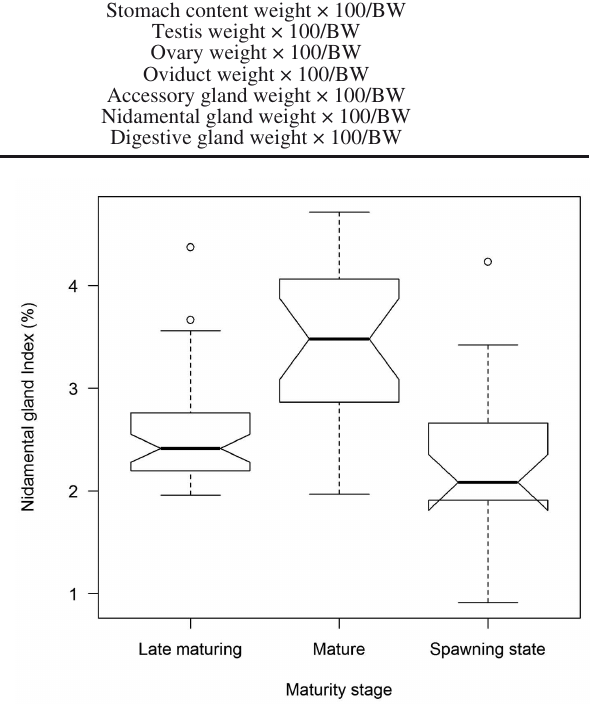
Fig. 1. – Box plots showing variation in nidamental gland somatic index among the three stages of maturity for Ommastrephes bar- tramii . The median (horizontal black lines within box plots) and its confidence interval (notches) also indicated. There were significant differences among the three stages (P<0.01, analysis of variance).